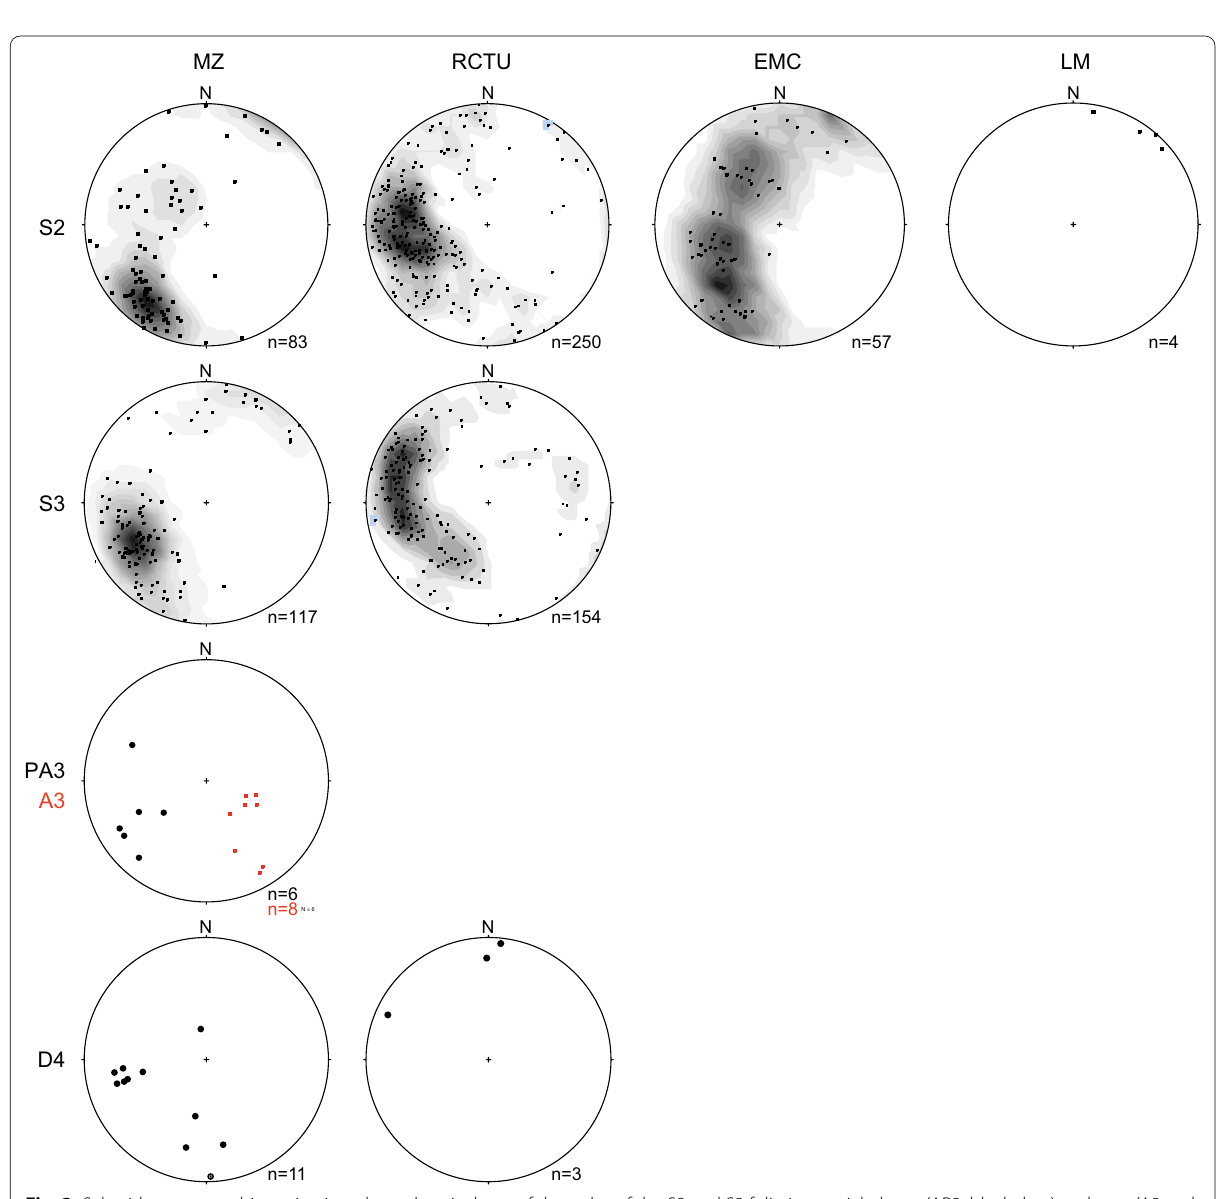
Fig. 3 Schmidt stereographic projections, lower hemisphere, of the poles of the S2 and S3 foliations, axial planes (AP3, black dots) and axes (A3, red dots) of D3 folding, and D4 decimetre-scale crenulation for the MZ, the RCTU, the EMC and the LM. Density contours are also reported for S2 and S3 foliations. In the MZ, the orientation of poles to S2 and S3 foliations strongly clustered around SW with a dip angle between 0 and